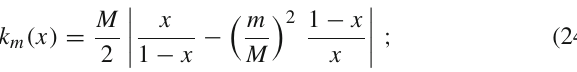
k + = k 0 − k z is the light-cone quark momentum fraction, n ( k ) the quark momentum density distribution predicted by the specific QM wave functions, and M and m are the nucleon and constituent quark masses, respectively. One can check